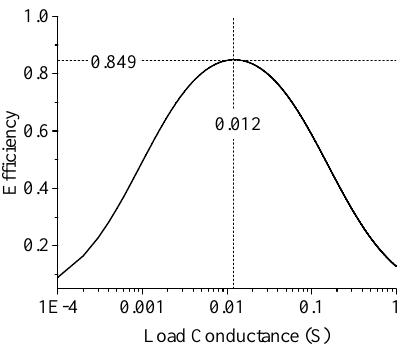
Figure 4. The simulated efficiency η as a function of varying load conductance for the given system of three transmitters and a single receiver. The load conductance is varied, while keeping the other system parameters at their optimal value.